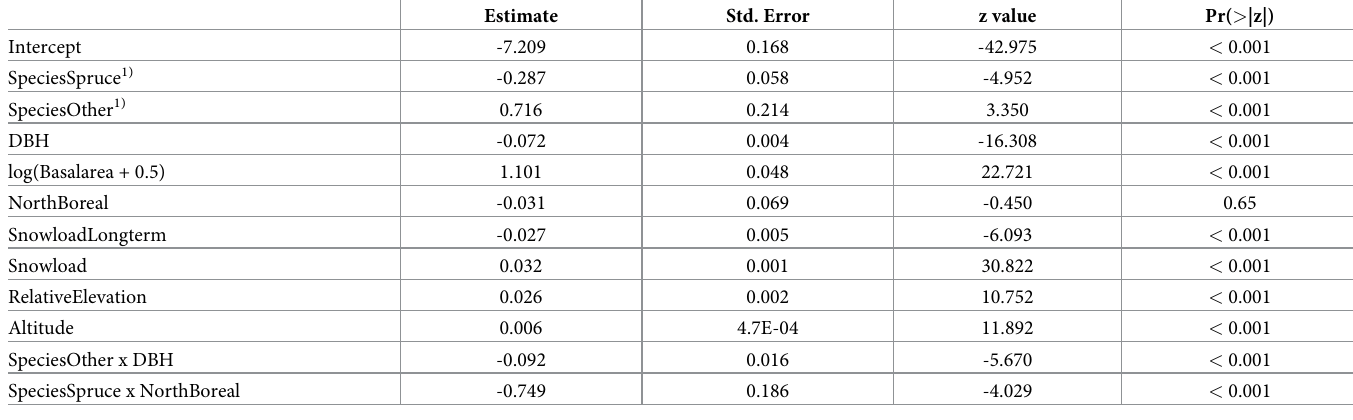
Table 3. Model results for the full GLM model. See full descriptions and units of the covariates in Table 2. Estimate Std.